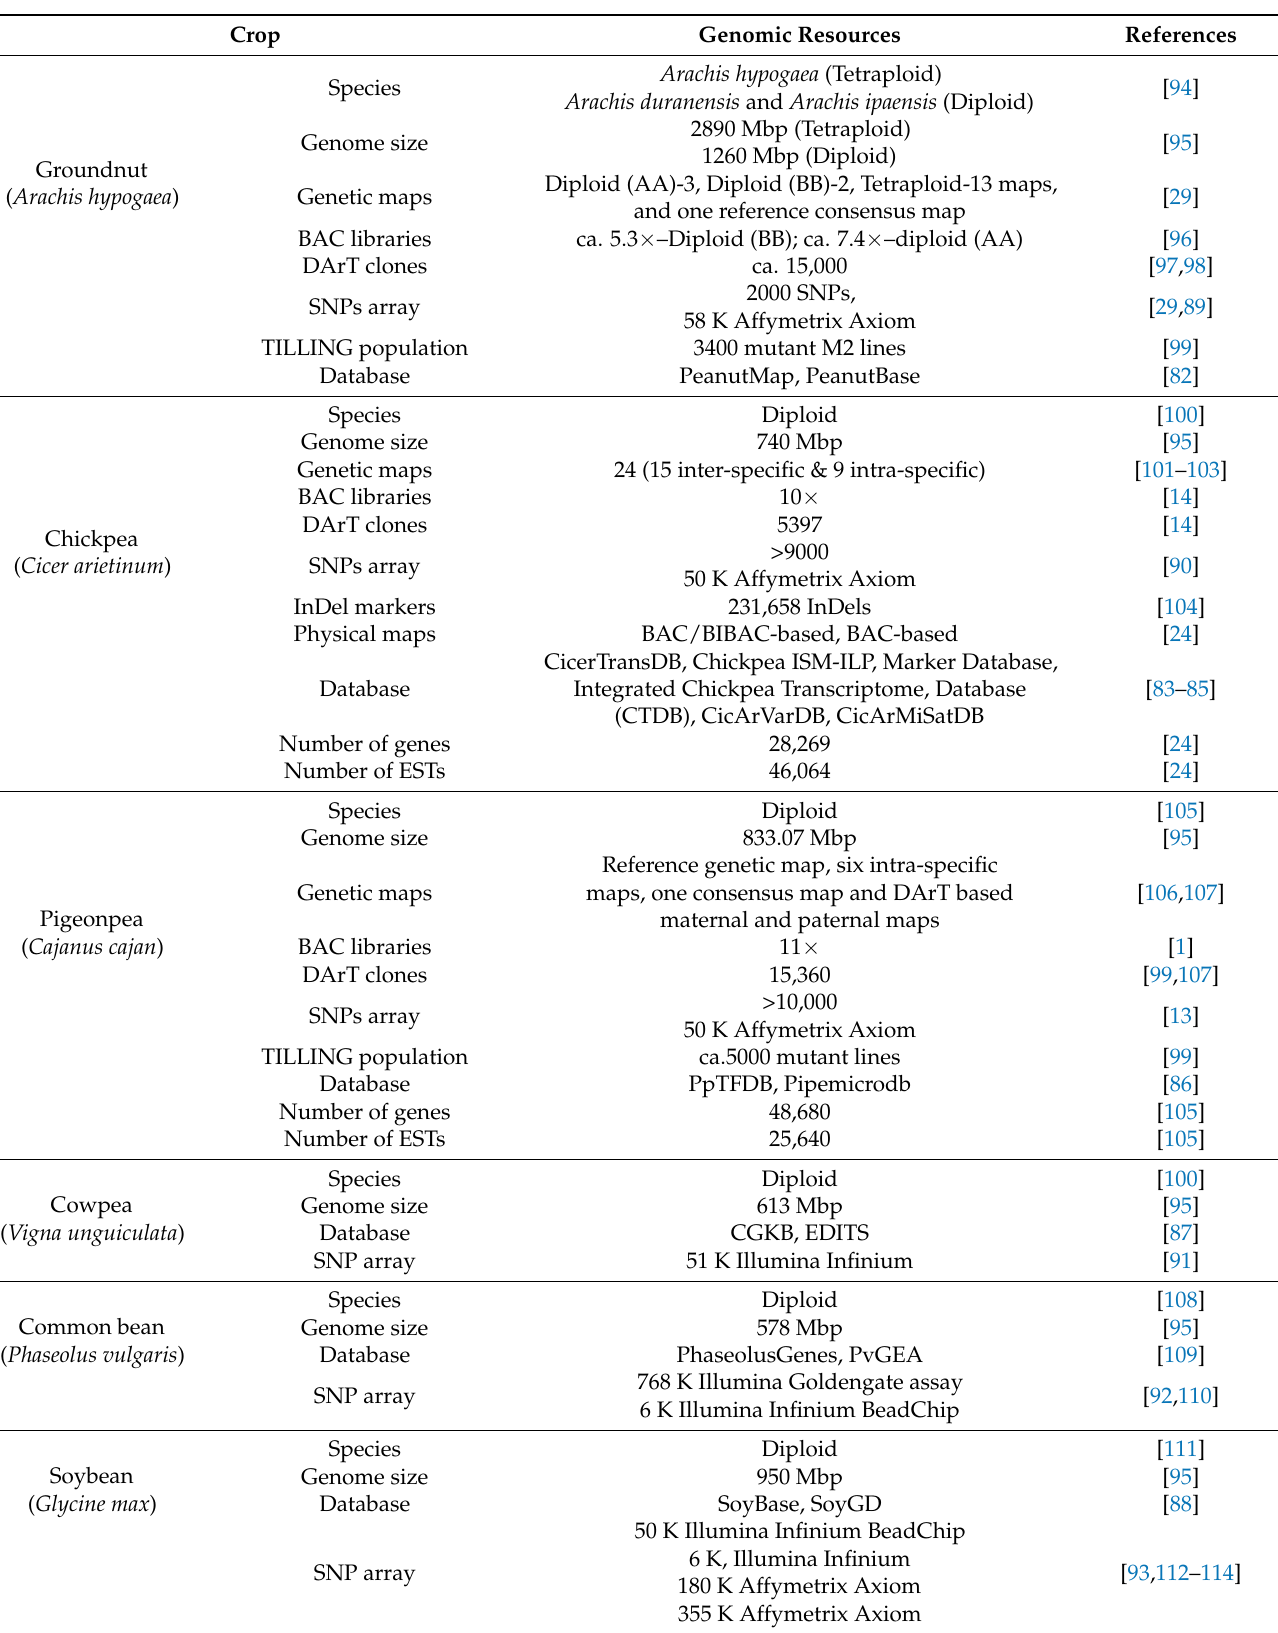
Table 1. Availability of genomic resources of important legume